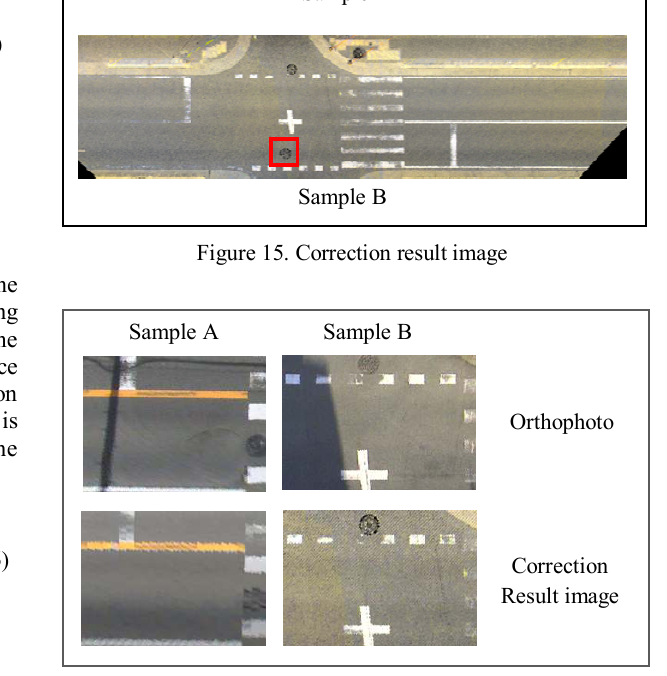
Figure 16. Comparison of visibility